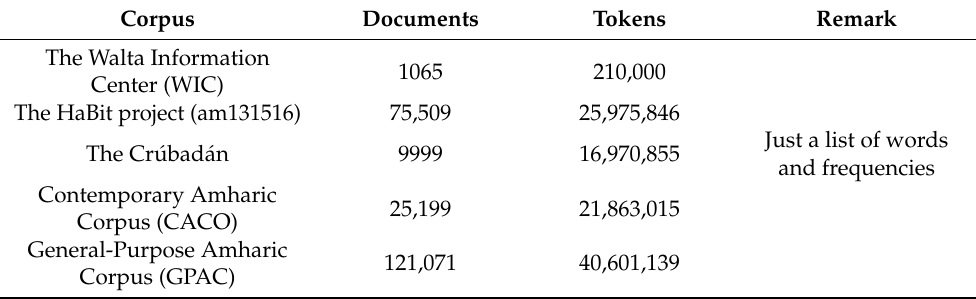
Table 1. The general-purpose Amharic Corpus (GPAC) compared with other Amharic corpora. Corpus Documents